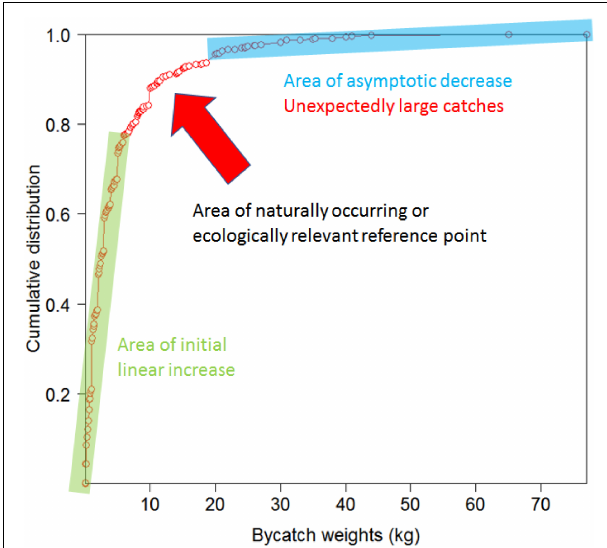
FIGURE 2 | Cumulative distribution curve for the weight of Actiniaria bycatch from the 2008–2018 New Zealand bottom trawl fishery in the SPRFMO Convention Area, where the initial part of the curve associated with linear increase is distinguished from the final part of the curve associated with asymptotic decrease. The area distinguishing between these two parts of the curve potentially indicates a naturally occurring or ecologically relevant reference point. Thresholds indicating unexpectedly large catches that indicate the models used to predict the distribution of VME indicator taxa are highly inaccurate should ideally fall to the right of such points, whereas “biodiversity weights” indicating increasing numbers of taxa in a single tow at weights below the threshold triggers indicating unexpectedly large catches should occur to the